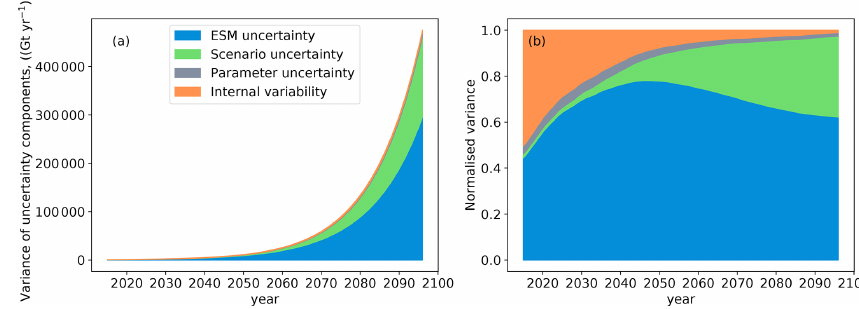
Figure 5. (a) Total and (b) relative variances of the different uncertainty components: choice of ESM (blue), different emission scenarios (green), different snow model parameters (grey), and internal variability (orange). The time period does not extend to 2100 because the variance splitting approach is applied to the decadal running means of the yearly